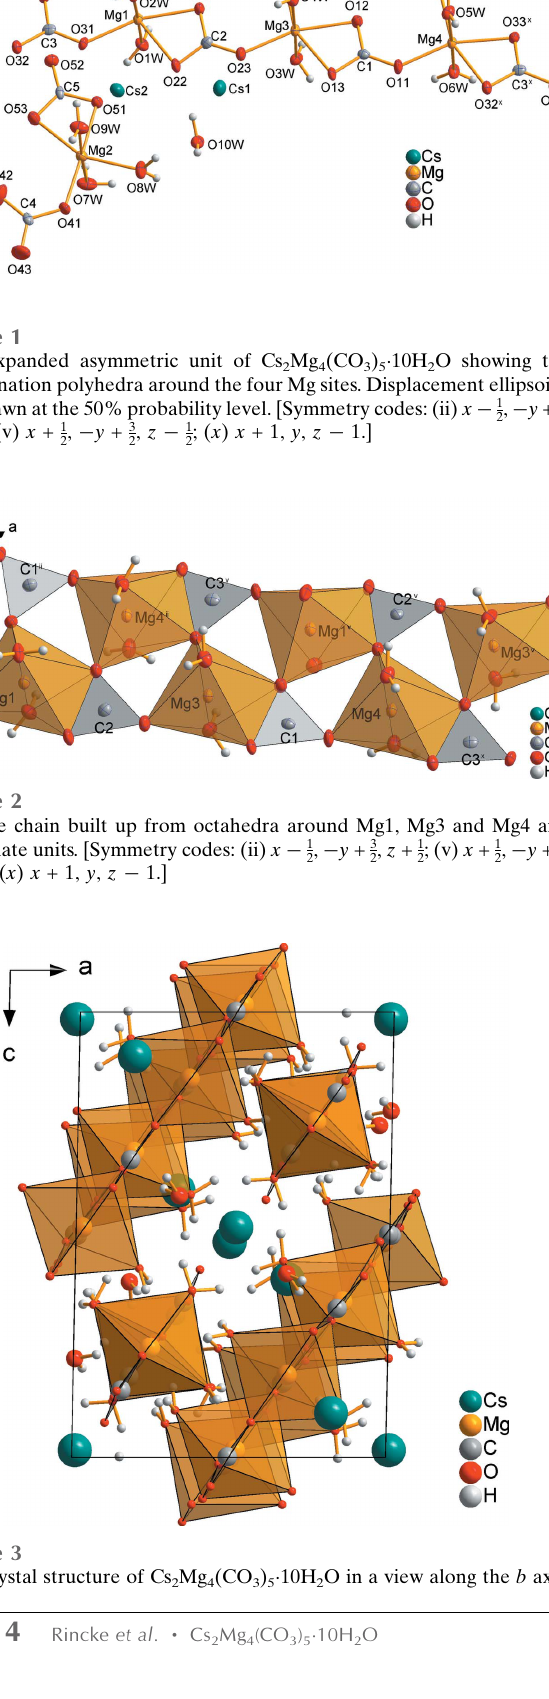
Figure 3 The crystal structure of Cs 2 Mg 4 (CO 3 ) 5 (cid:2) 10H 2 O in a view along the b axis.